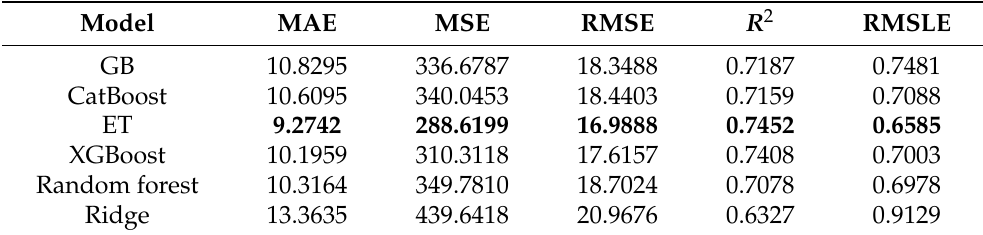
Table 4. The results on testing dataset for 6 models. AS in the training set, ET has the best performance.